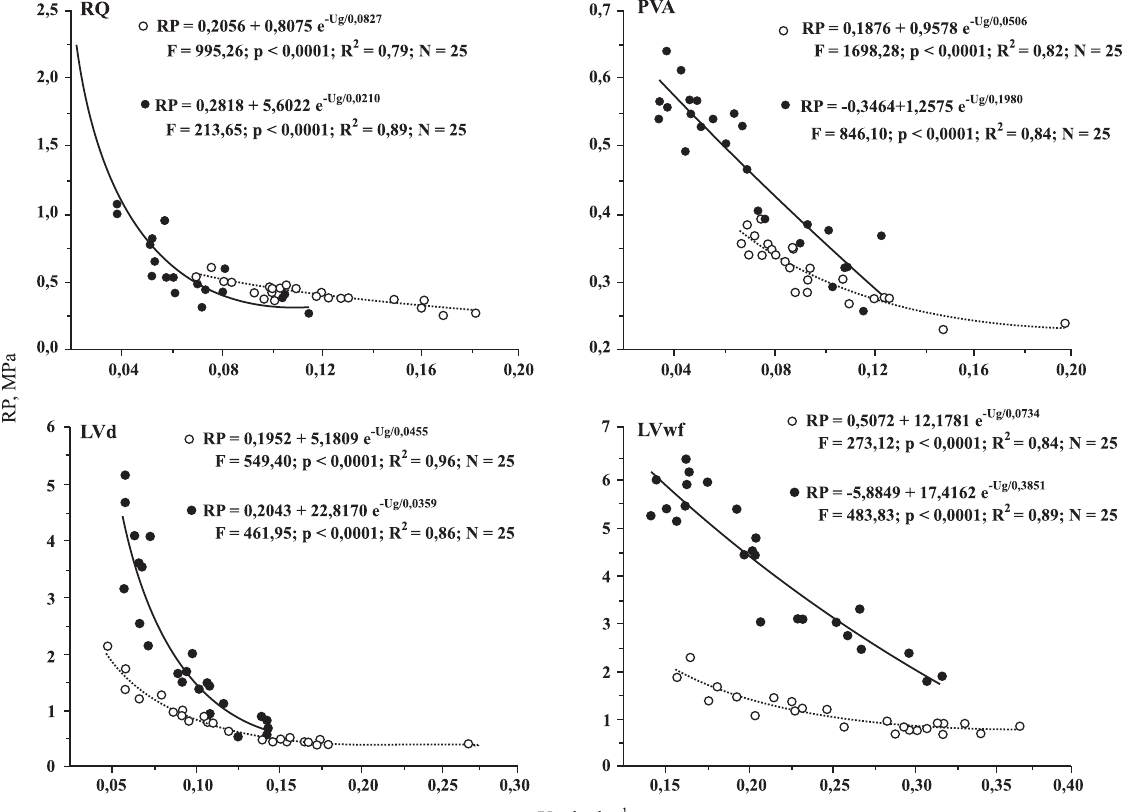
Figura 1. Curvas de resistência dos solos à penetração: Neossolo Quartzarênico (RQ), Argissolo Vermelho- Amarelo (PVA), Latossolo Vermelho distrófico (LVd) e Latossolo Vermelho acriférrico (LVwf), nas diferentes intensidades de compactação ( D1 e